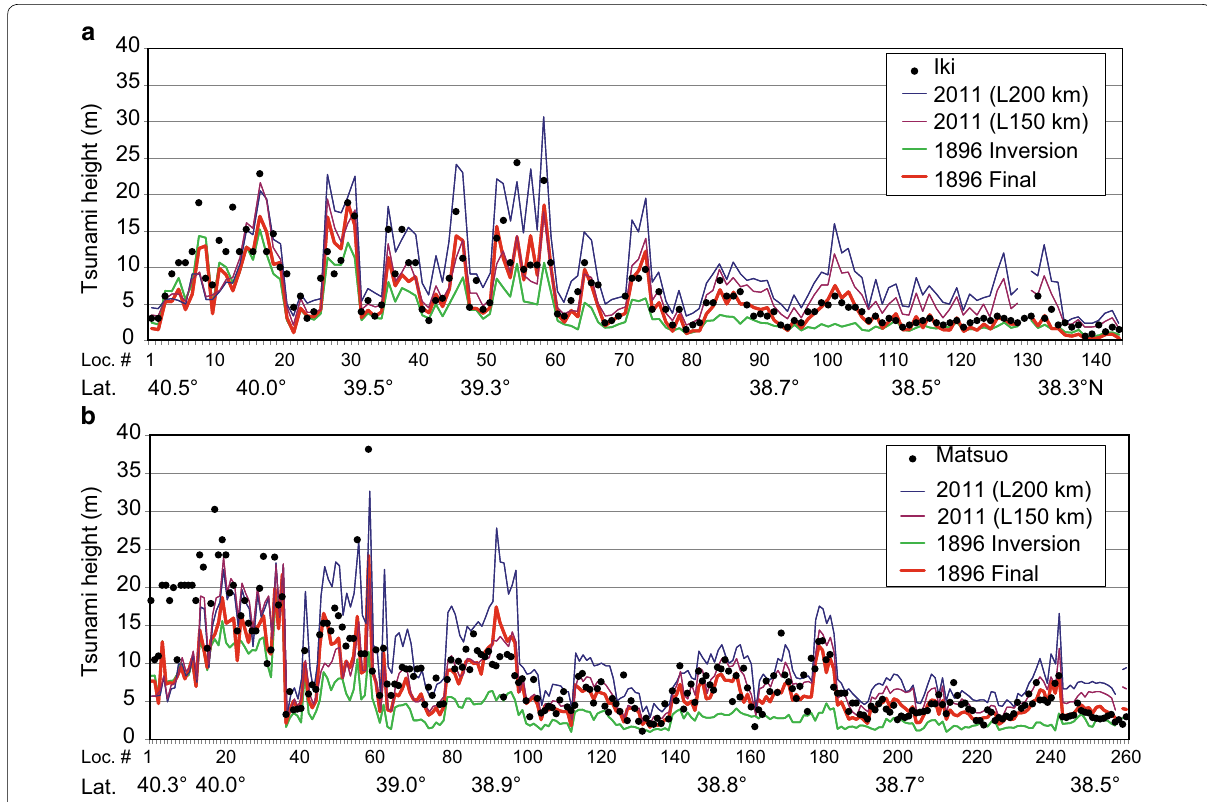
Fig. 3 Tsunami heights on the Sanriku coast reported by ( a ) Iki (1897) and ( b ) Matsuo (1933) are shown by black circles. Computed tsunami heights on 75 m grids for the four different models are shown by colored lines. Note that the scale for horizontal axis is location numbers (Additional file 1: Table S1, Additional file 2: Table S2), not distance. The latitudes for the locations are also